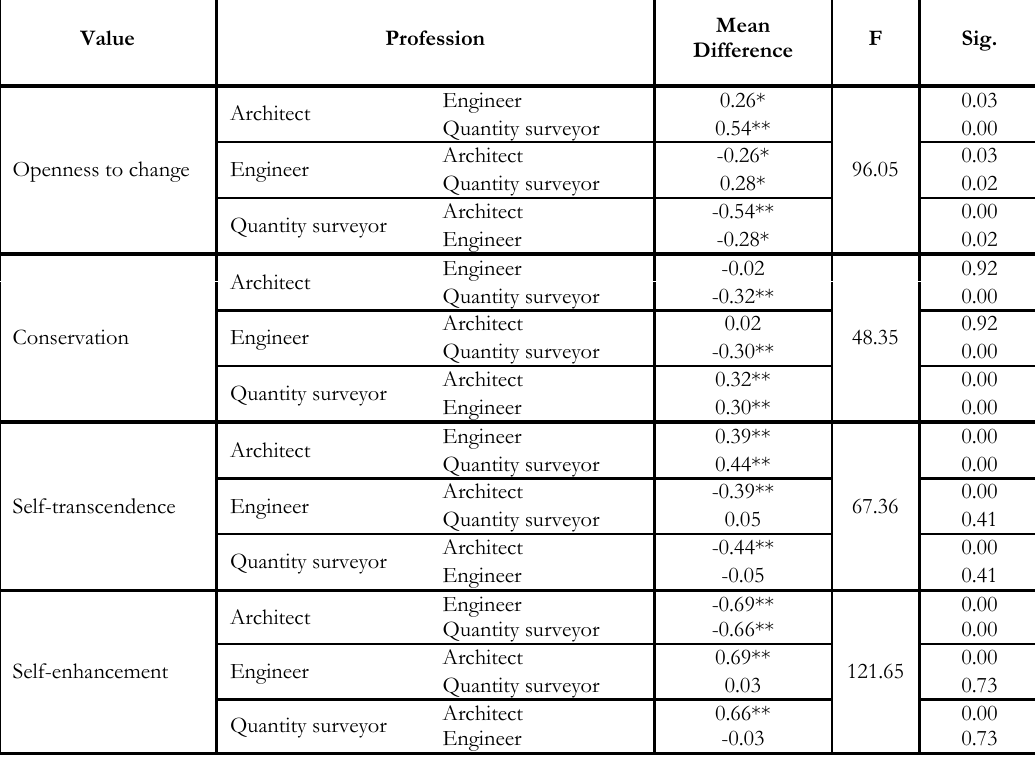
Table 6: Comparative analysis of the professions based on the 4 higher-order value types Value